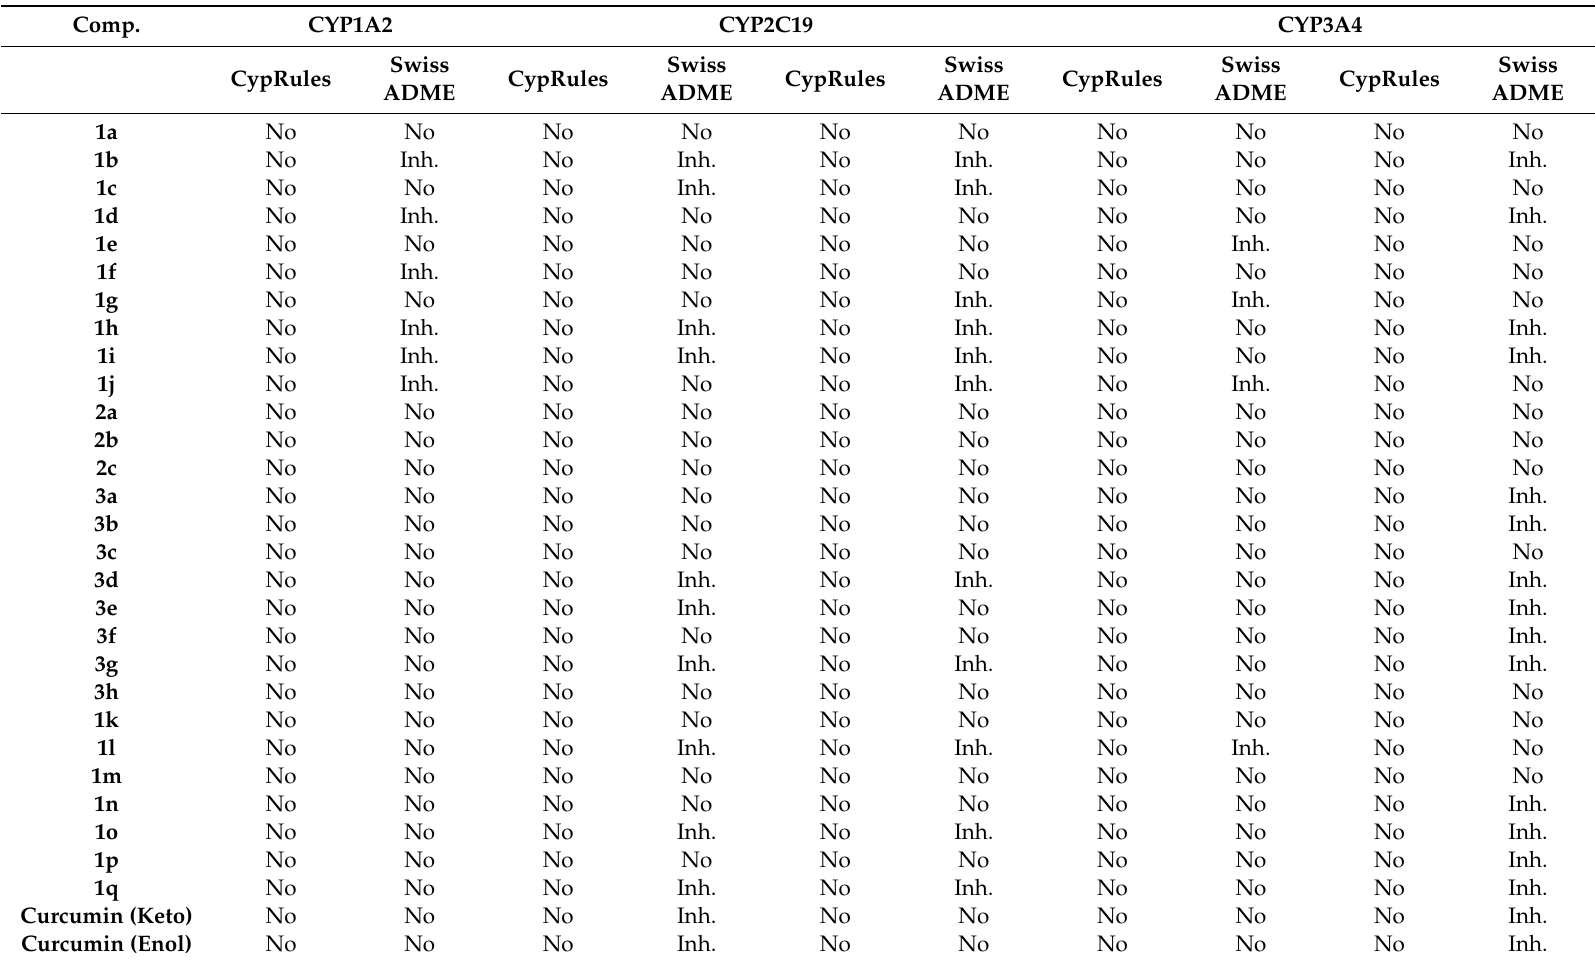
Table 3. Prediction of metabolism (CYP) and excretion using the CypRules rids present mutagenicity in the Ames test and the SwissADME platforms.